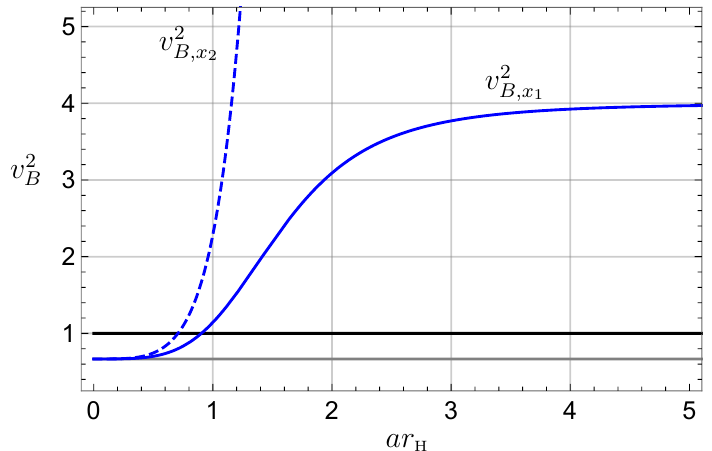
Figure 1 . Butter(cid:13)y velocity squared v 2 versus the dimensionless parameter ar . The continuous H B curve represents the butter(cid:13)y velocity along the x 1 -direction, while the dashed curve represents the butter(cid:13)y velocity along the x 2 - and x 3 -directions. The horizontal grey line corresponds to the conformal result v 2 = 2 = 3, while the horizontal black line corresponds to the speed of B